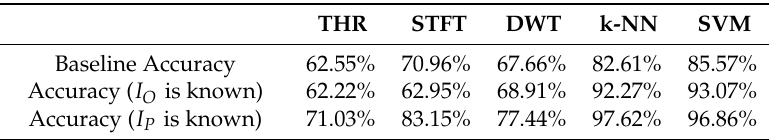
Table 6. Context effects: orientation and